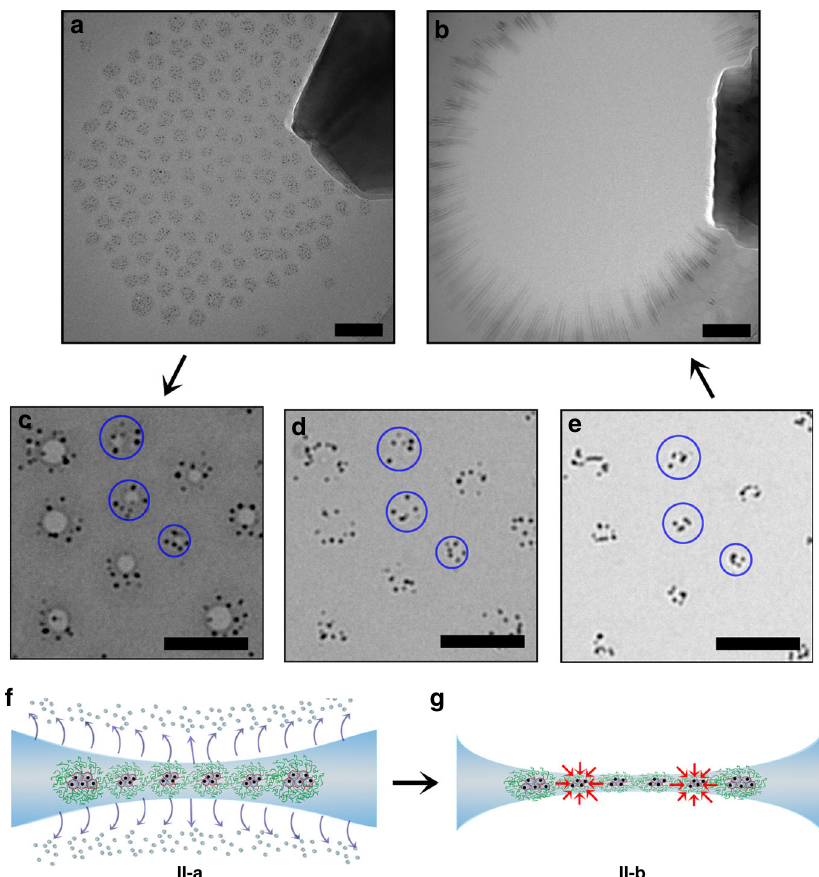
Fig. 4 Local and global migration in dendrimicelle superstructures under electron beam irradiation. a CryoTEM micrograph of a dendrimicelle superstructure obtained from dendrimicelles encapsulating ninth-generation PAMAM dendrimers in their core, with an Au 1024 nanoparticle encapsulated inside every dendrimer. b CryoTEM micrograph after the electron beam-induced nanoexplosion of the dendrimicelle superstructure. c – e Enlarged sections of the superstructure at various time points during the electron beam irradiation, showing that upon prolonged irradiation, the contrast provided by the dendrimicelle core is reduced, and the gold nanoparticles appear closer together. The blue circles in c – e represent the original dendrimicelle core area, and are drawn to visualize the observed dendrimicelle core shrinkage. f , g Schematic illustration of the different stages during the nanoexplosion. CryoTEM sample preparation provides a dendrimicelle superstructure located at the thinnest part of the biconcave water fi lm. f Extensive electron irradiation results in the evaporation of water from the biconcave thin fi lm, leading to the formation of a freestanding polymer fi lm in the center of the grid hole, in which the dendrimicelle cores seems to have shrunk, but more likely the gold particles have been excreted from the dendrimer voids and group together ( g ). The scale bars are 100